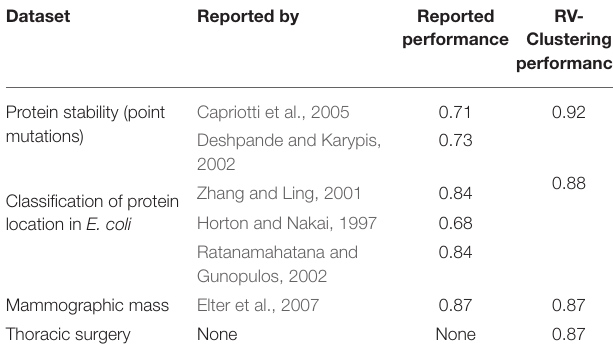
TABLE 2 | Comparison of reported performance metrics for the studied experimental datasets.